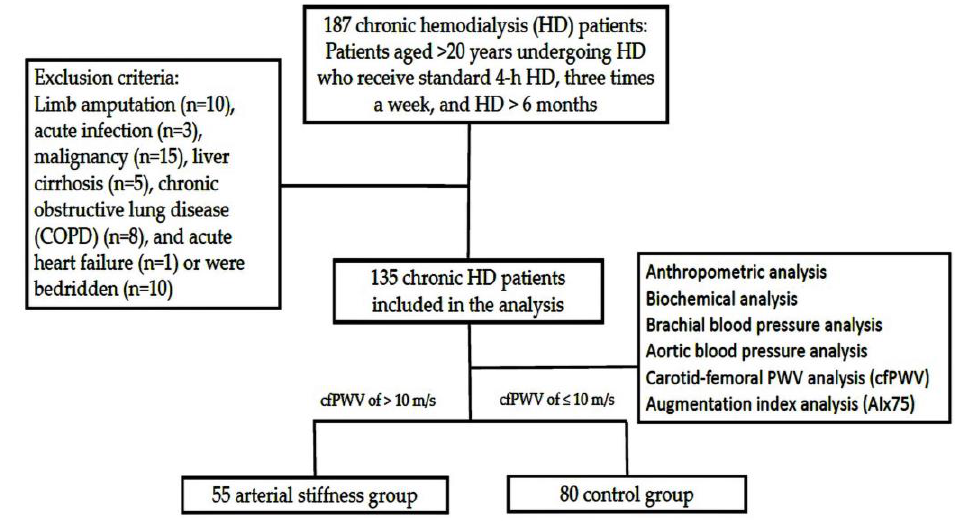
Figure 1. Flow chart of this study.